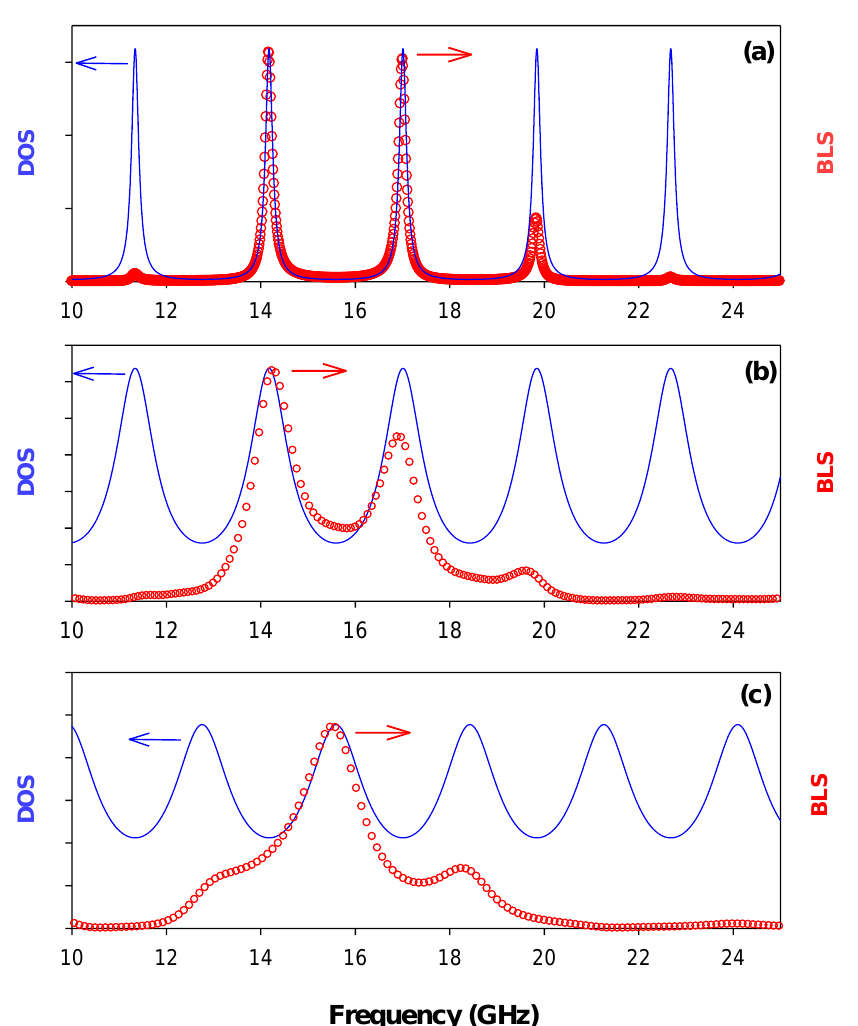
= 0.1 𝑍 = ( a ), 𝑍 2 1 2